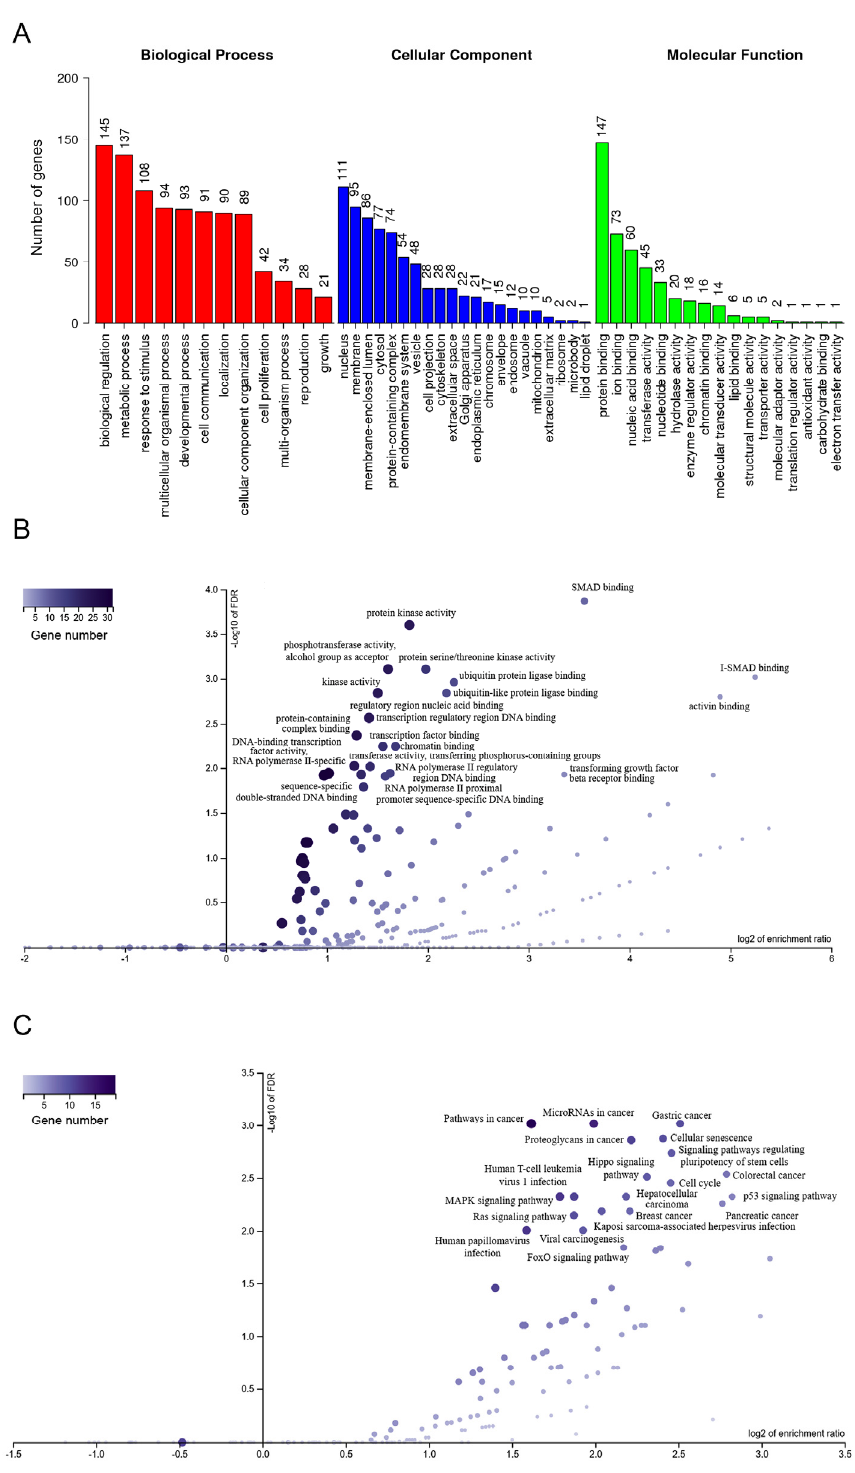
Figure 3. Functional enrichment analysis of the DE exosomal miRNA targets in SLE patients with LN. ( A ) GO analysis of the DE targeted genes. The vertical axis indicates the number of targeted genes in a particular hierarchical cluster in biological process, cellular component and molecular function. ( B ) Volcano plot of GO terms enrichment analysis, according to the enrichment ratio (horizontal axis) and –log10(FDR) (vertical axis). The top 20 significant GO terms are described. ( C ) Volcano plot of the KEGG pathway enrichment analysis. The top 20 significant KEGG pathways are described. The size and color of the dot (enriched gene set) is proportional to the size of the category.